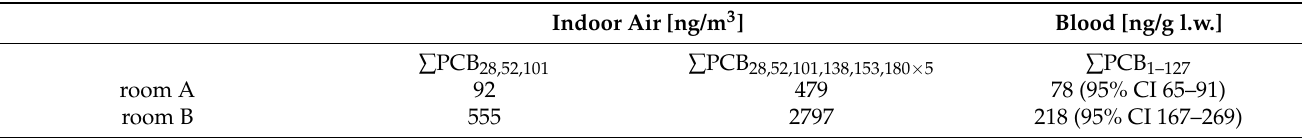
Table 4. Transfer of results from regression analyses to real indoor air exposure conditions. Exposure to the sum of the three lower-chlorinated marker congeners ( ∑ PCB 28,52,101 ) and total PCB concentration ( ∑ PCB 28,52,101,138,153,180 × 5 ) in indoor air (ng/m 3 ) and related blood burden of ∑ PCB 1–127 (ng/g